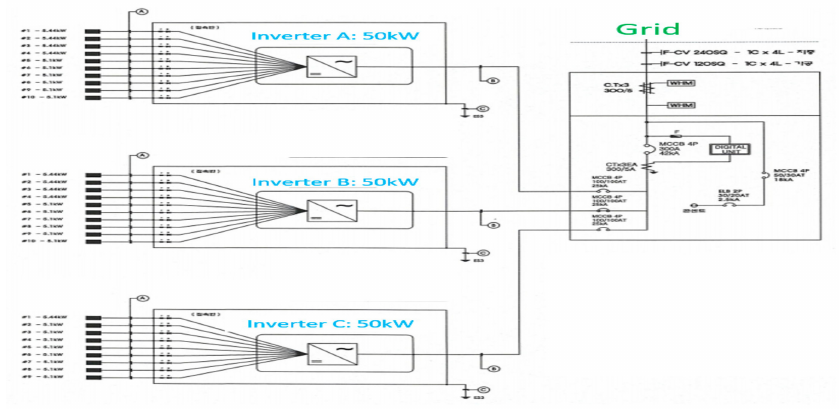
Figure 3. Proposed wiring diagram of the solar power system.